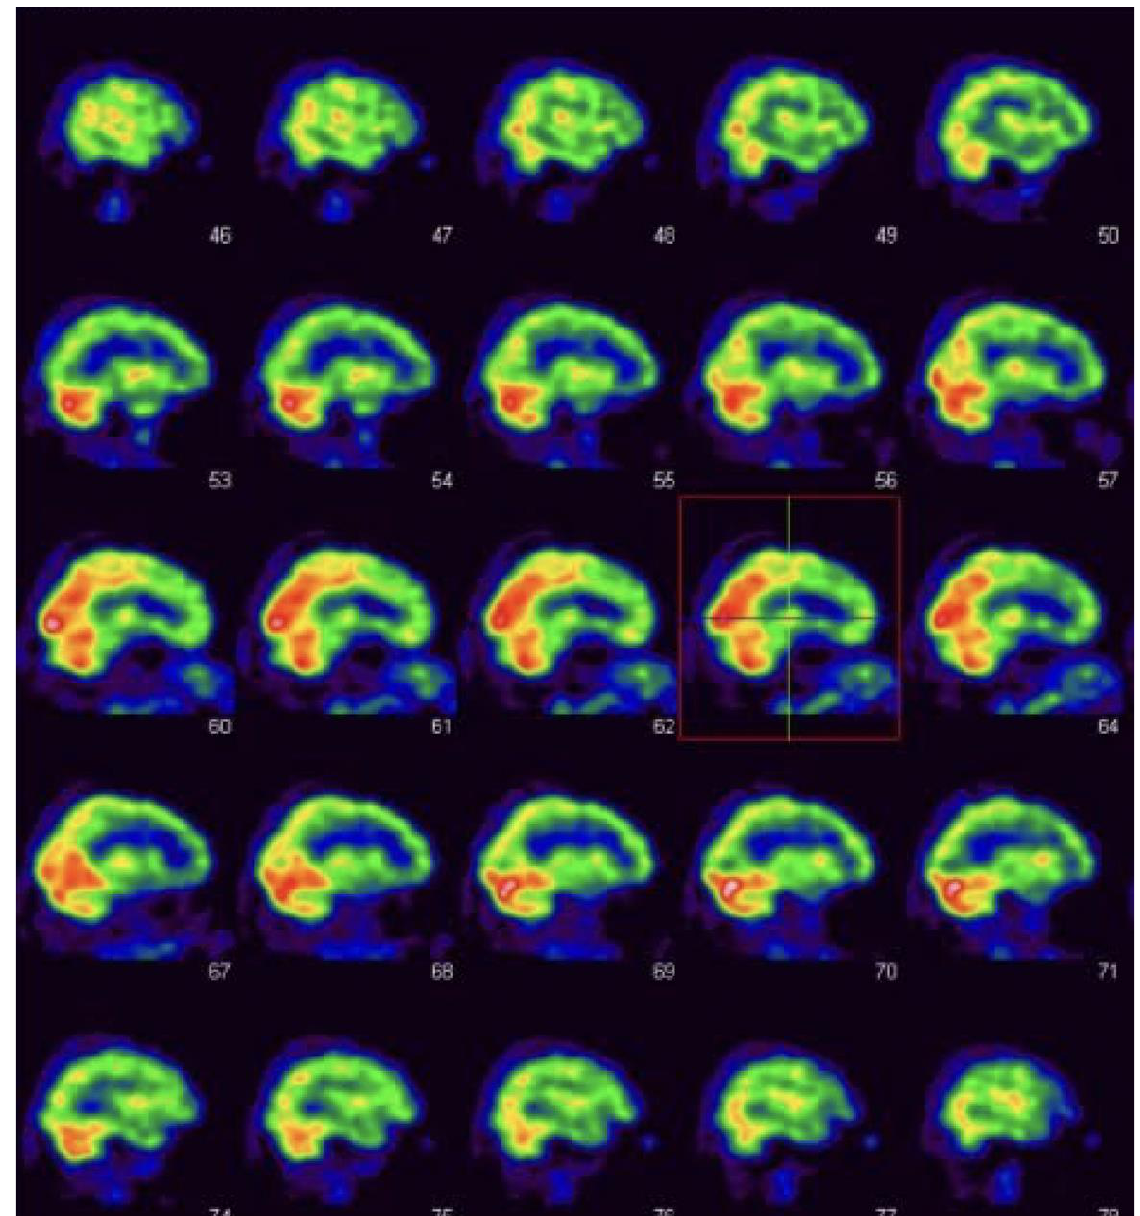
Figure 2. Frontal hypoperfusion in PSP-P — sagittal plane. Red Box: Pronounced decrease of perfusion within the middle frontal gyrus.